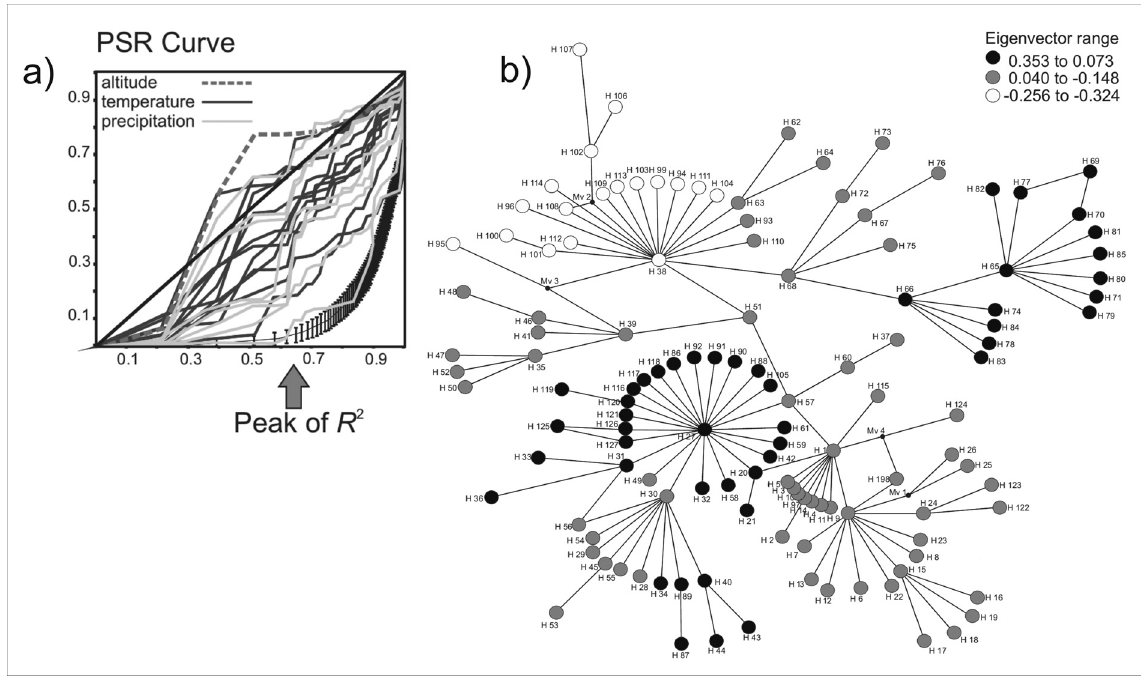
Figure3 -Climaticandaltitudevariablesfor Petunia andhaplotypeevolutionaryrelationships:(a)phylogeneticsignal-representation(PSR)curvesofal- titude (dashed line), temperature (black lines), and precipitation (light grey lines) variables. The lowermost curve with the vertical bars is the null PSR curve,representingtheabsenceofphylogeneticpatternsinthedata,obtainedfrom103randomizations.Thediagonalsolidlinerepresentstheexpectation underBrownianMotionevolution.(b)HaplotypeconnectivitynetworkbasedoncpDNAintergenicspacers trnH-psbA and trnS-trnG distancematricesin Petunia . Haplotypes are consecutively numbered, with node shades representing the 4 th PCoA eigenvector, which showed the greatest R 2 shift (Table 3). Eigenvectors choice was based on dramatic changes in the of correlation values, giving origin to the classes that were plotted in the